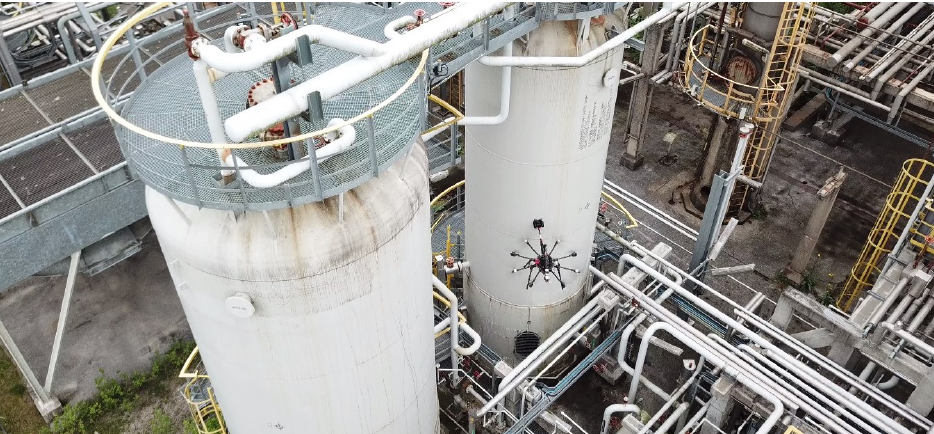
Figure 1. AeroX performing an ultrasonic thickness measurement in a refinery located in Germany in 18 July. The exact location cannot be disclosed due to confidentiality